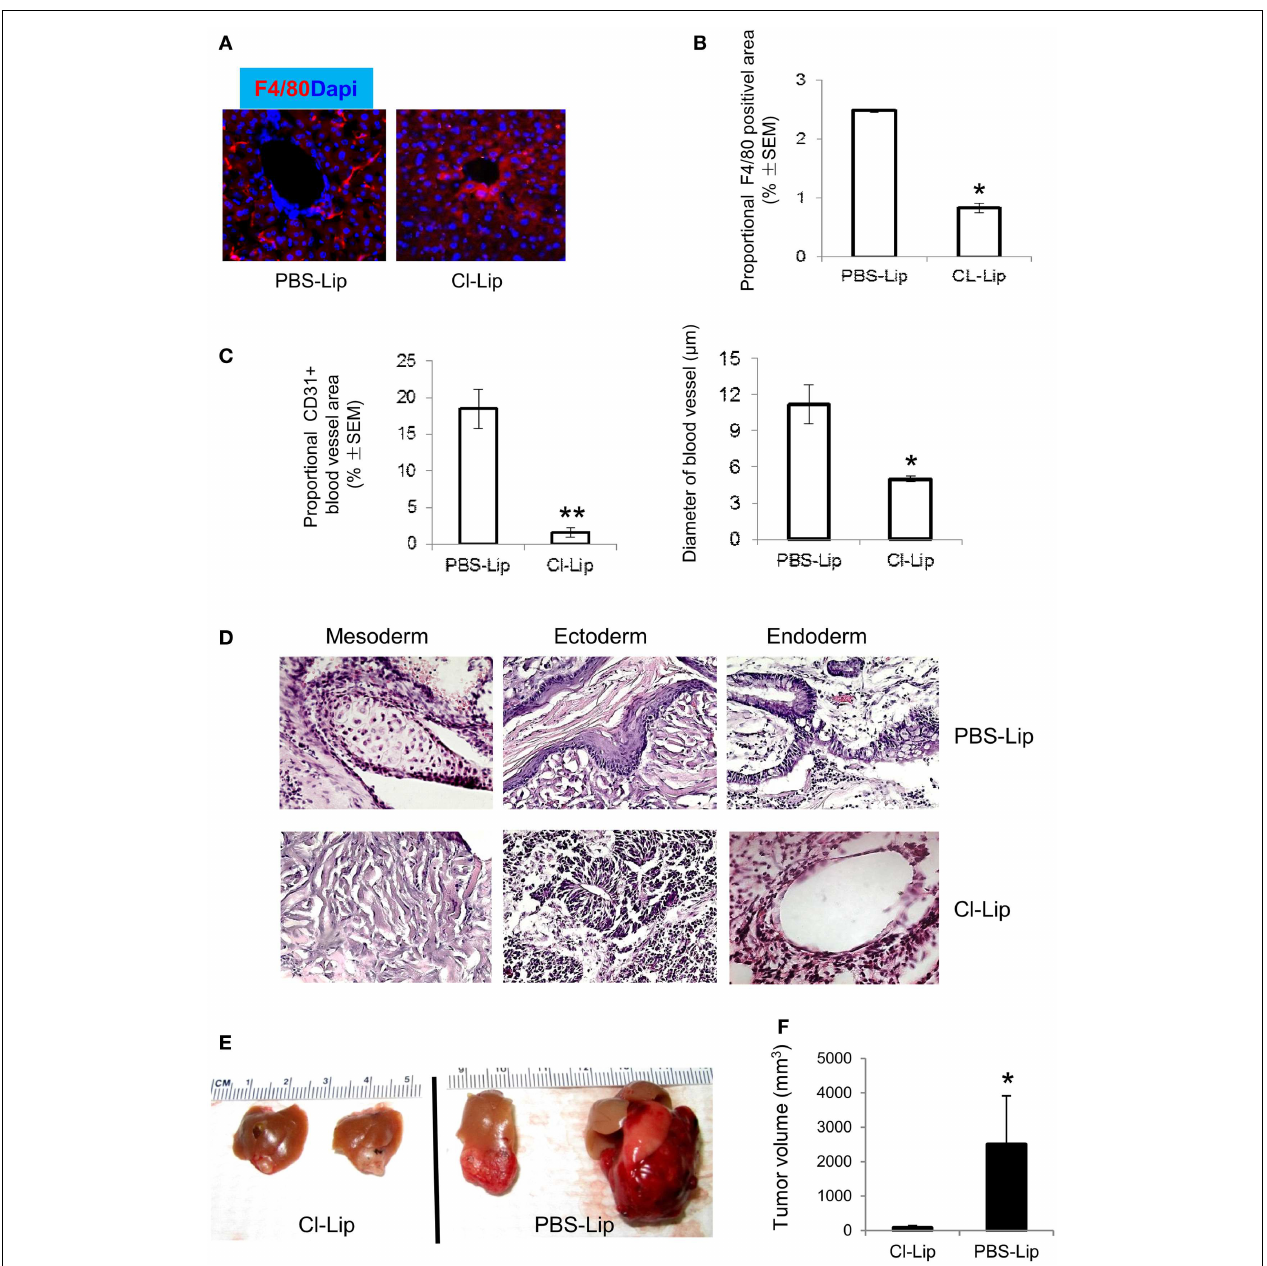
macrophages (B) , density of blood vessels stained for CD31 [ (C) , left], size of blood vessels [ (C) , right], HE staining (D) , and representative images of teratomas (E) in teratomas from Cl-Lip- or PBS-Lip-treated mice at 4weeks after ESC transplantation. (F) Average teratoma size at 4weeks after ESC transplantation in the Cl-Lip and PBS-Lip treated groups. * p < 0.05, ** p < 0.001, n = 5, two-sidedWilcoxon test. Data are represented as mean ±